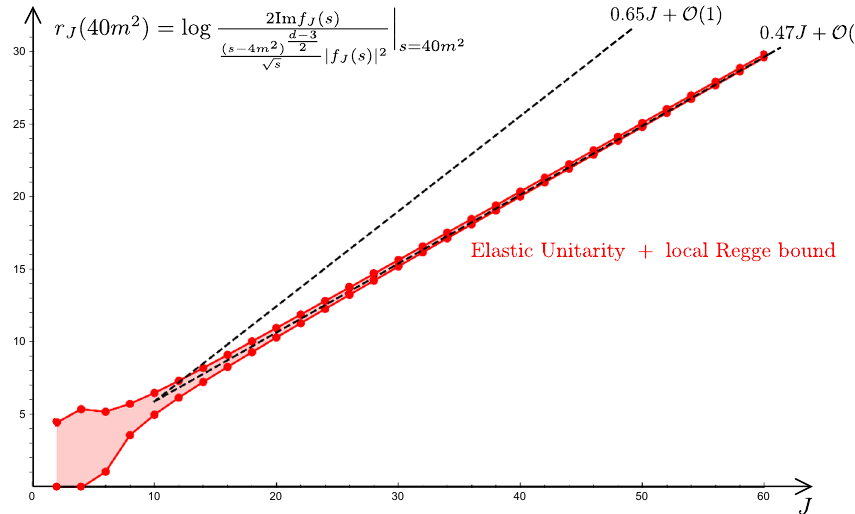
Figure 14 . Inelasticity ratio r J ( s = 40 m 2 ) , (6.20), as a function of spin J . The region between the red curves is the analytic prediction for a function that satisfies elastic unitarity and the local error bound (7.8) with parameters (7.20) as taken from the numerics. For a function that satisfies elastic unitarity, the presence of the Steinmann shadow region where ρ ( s, t ) = 0 , see figure 11, gives r J (40 m 2 ) ∼ 0 . 47 J at large J . This is the asymptotic behavior of the red curves. On the other hand, a function that has ρ ( s, t ) 6 = 0 in the Steinmann shadow region is expected to behave as r J (40 m 2 ) ∼ log λ ( z 1 ) | ∼ 0 . 65 J this is what numerics produces for any finite N max s =40 m 2